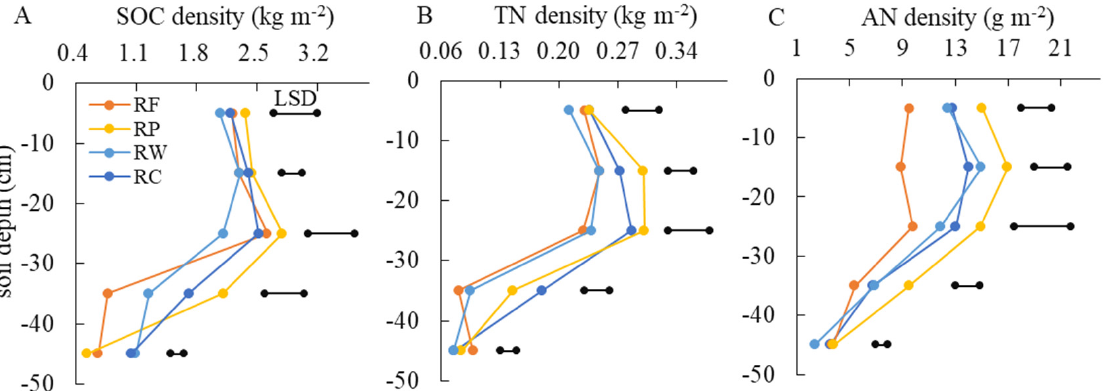
Figure 1. The vertical difference of soil organic C ( A ), total N ( B ) and available N ( C ) densities among rotations. LSD bars represent least significant difference ( p = 0.05) among rotations at the same soil depth. The same as below.